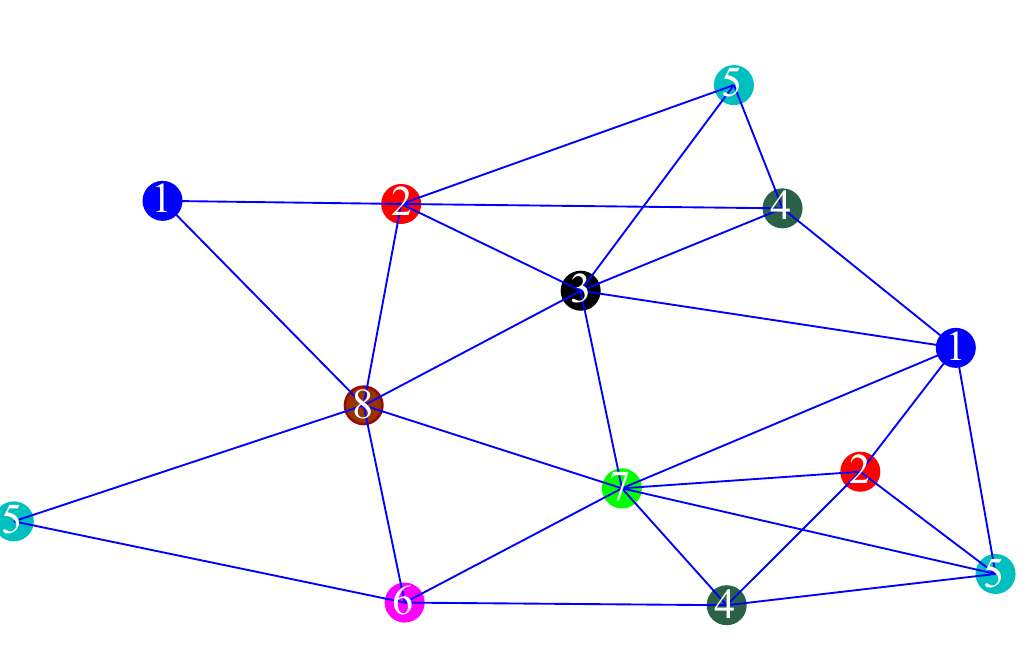
Figure 1. A possible second-order coloring scheme for a network with |V| = 13